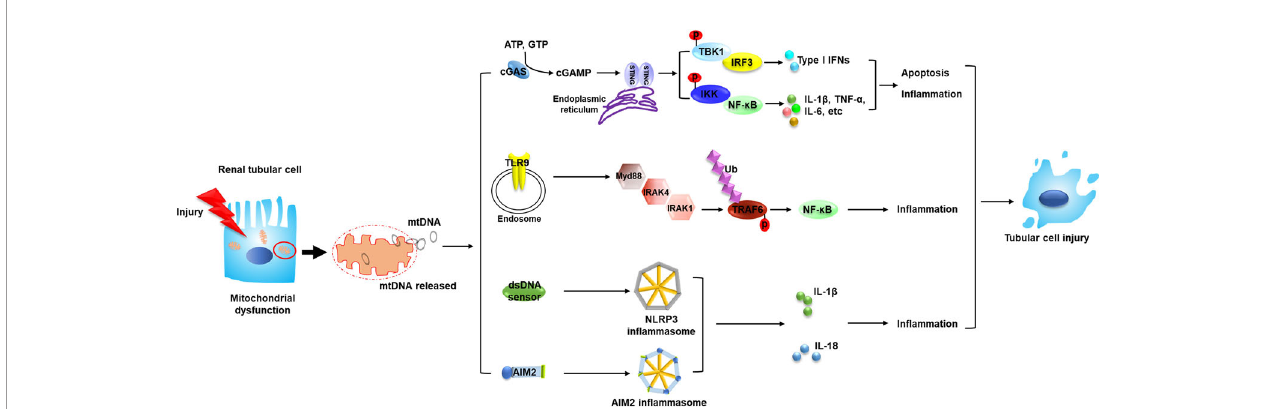
FIGURE 1 | Circulating mtDNA triggers the innate immune system through several mechanisms and mediates the pathogenesis of AKI. The occurrence of AKI is closely associated with mitochondrial dysfunction in renal tubular cells. Tubular mitochondrial damage leads to mtDNA leakage into cytosol and extracellular space. Circulating mtDNA binds with different DNA sensors and activates several innate immune signaling pathways such as cGAS – STING, TLR9-Myd88-NF- k B and NLRP3 in fl ammasome, leading to tubular in fl ammation and injury, which contributes to the progression of AKI. MtDNA, mitochondrial DNA; STING, stimulator of interferon genes; TBK1, TANK binding kinase 1; IKK, the I k B kinase; p, phosphorylation; IRF3, interferon regulatory factor 3; NF- k B, nuclear factor kappa B; TNF, tumor necrosis factor; TLR9, toll-like receptor 9; Myd88, myeloid differentiation factor 88; IRAK, interleukin 1 receptor associated kinase; Ub, ubiquitylation; TRAF6, TNF receptor associated factor 6; AIM2, absent in melanoma 2; IL,